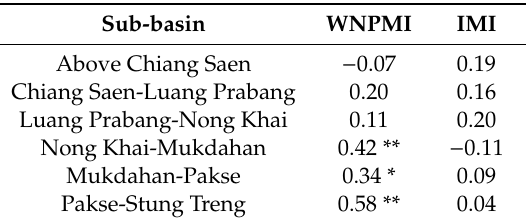
Table 2. Correlation coe ffi cients between monsoon index (WNPMI and IMI) and river flow in each sub-basin during JJAS